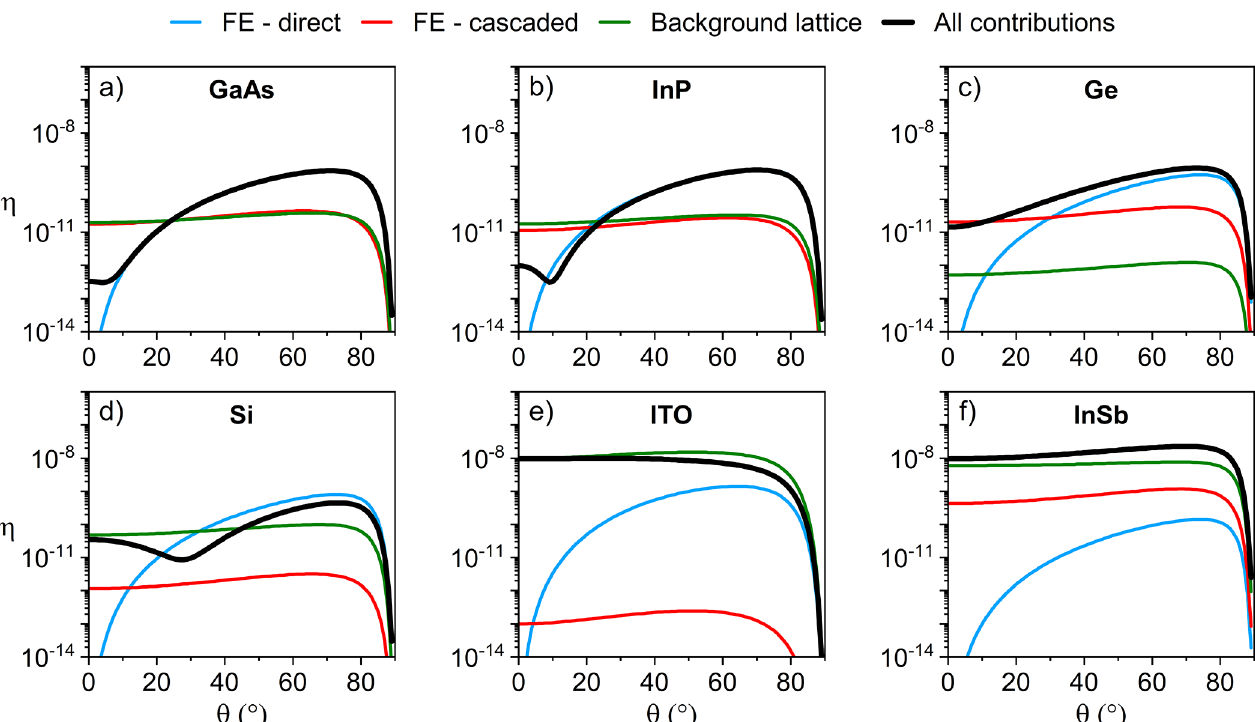
Fig. 3. THG ef fi ciency h of a highly doped semiconductor slab as a function of the incident angle u and for the different nonlinear sources, organized by material. Plots (a) – (f) take into account GaAs, InP, Ge, Si, ITO, and InSb